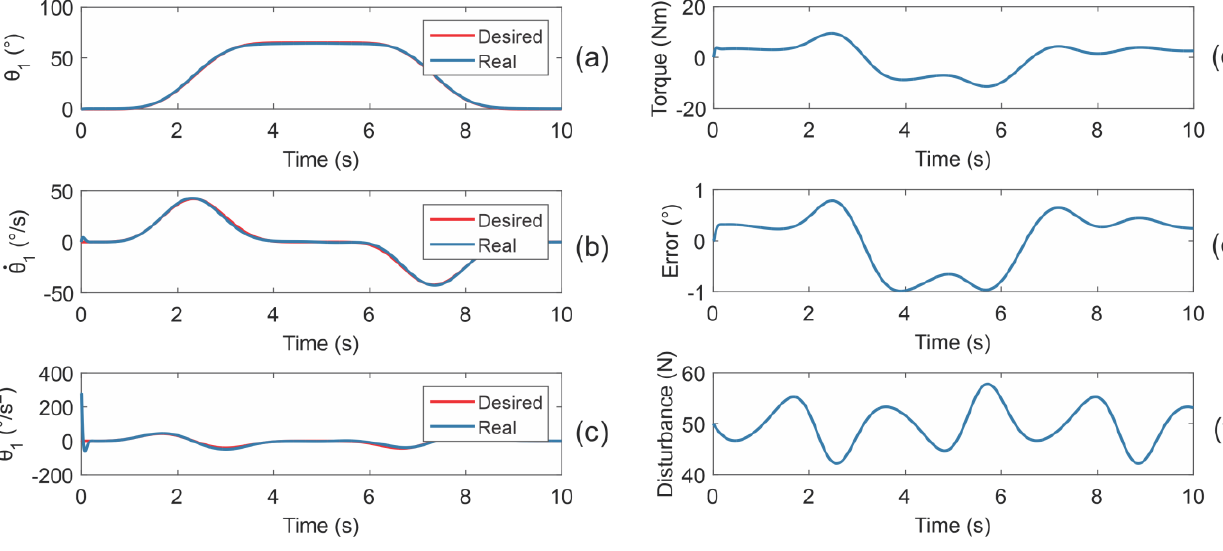
Figure 14. Reference trajectory tracking simulation with an unknown disturbance input. ( a ), ( b ), and ( c ) are respectively the angular position, velocity, and acceleration of θ 1 , ( d ) is the torque, ( e ) is the error, and ( f ) is the disturbance.